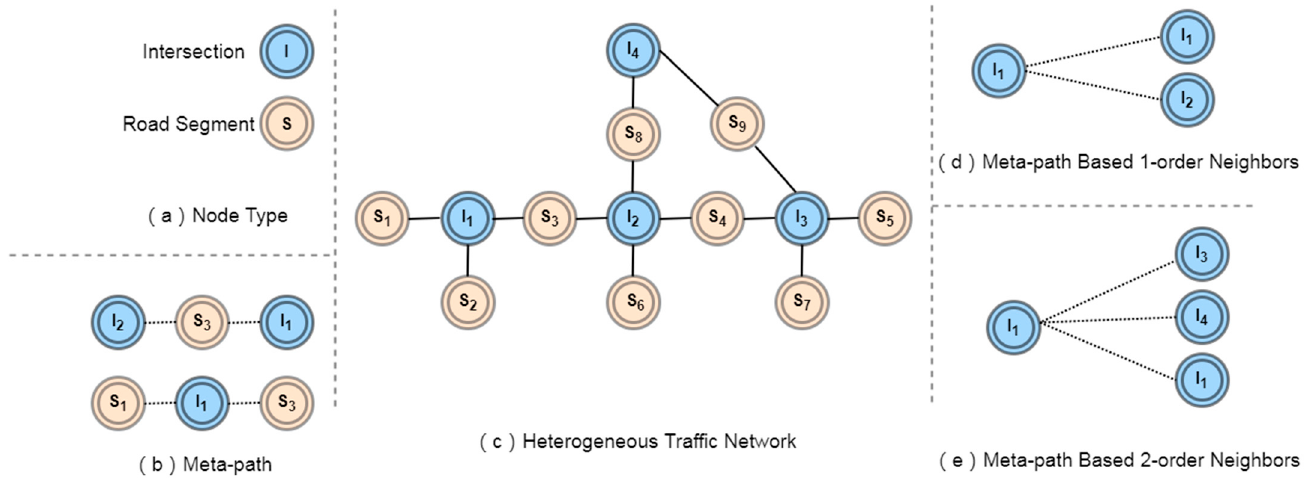
Figure 1. An illustrative example of a heterogeneous traffic network.